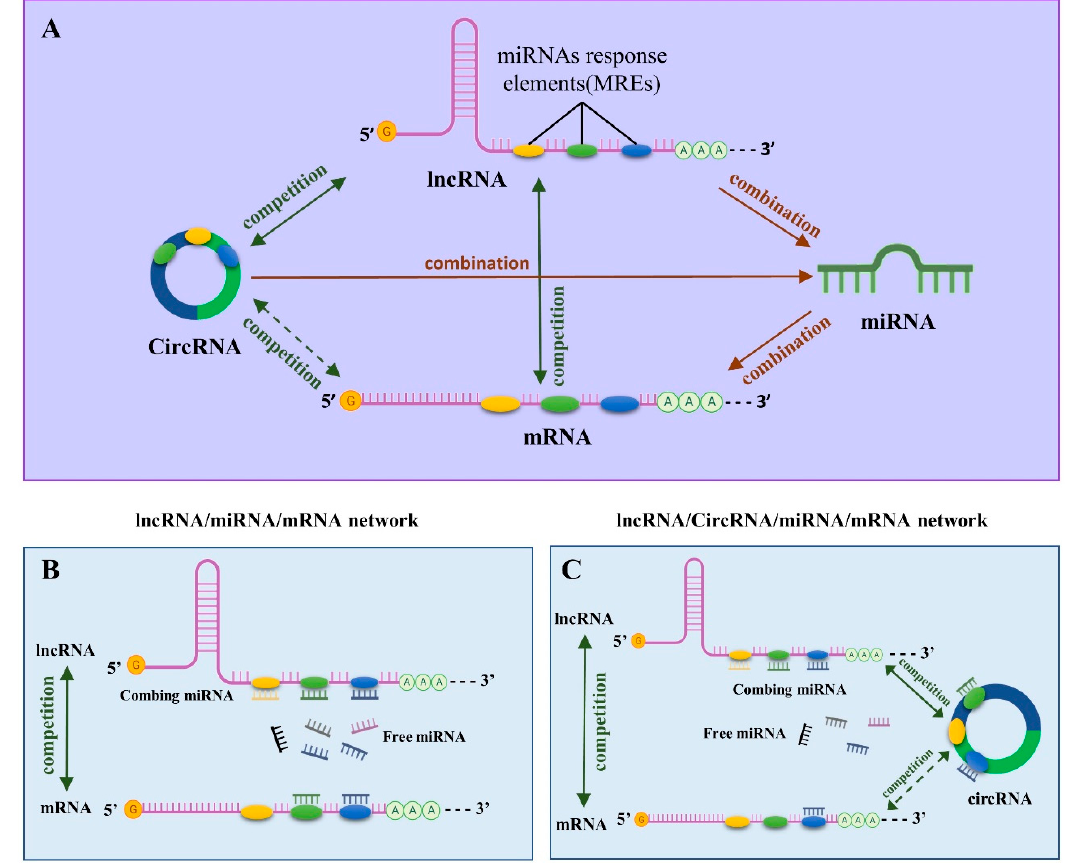
Figure 3. Regulatory mechanism of ceRNA network. ( A ) Relationship of mRNA, miRNA, circRNA, and lncRNA in ceRNA network hypothesis; ( B ) specific regulation mechanism of lncRNA-mediated ceRNA network. LncRNA regulates the expression of mRNA by competing for the opportunity of binding to miRNA; ( C ) specific regulation mechanism when lncRNA and circRNA are as ceRNA simultaneously. lncRNA and circRNA simultaneously compete with mRNA for the opportunity to bind to miRNA to regulate mRNA expression. LncRNA, circRNA, and mRNA compete with each other.